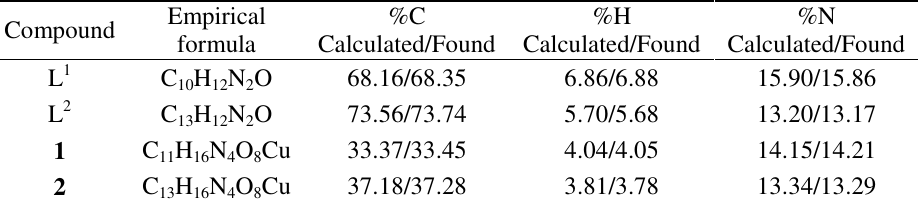
Figure 2. Structure of Complex [Cu(L) Table 1. Elemental analysis of the ligands and complexes